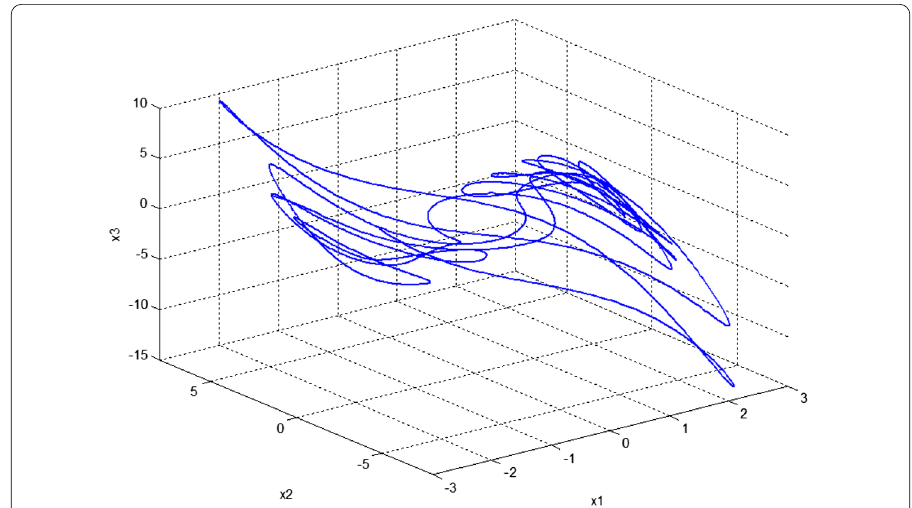
Figure 8 Chaos in the behavior of Arneodo fractional order system (22)